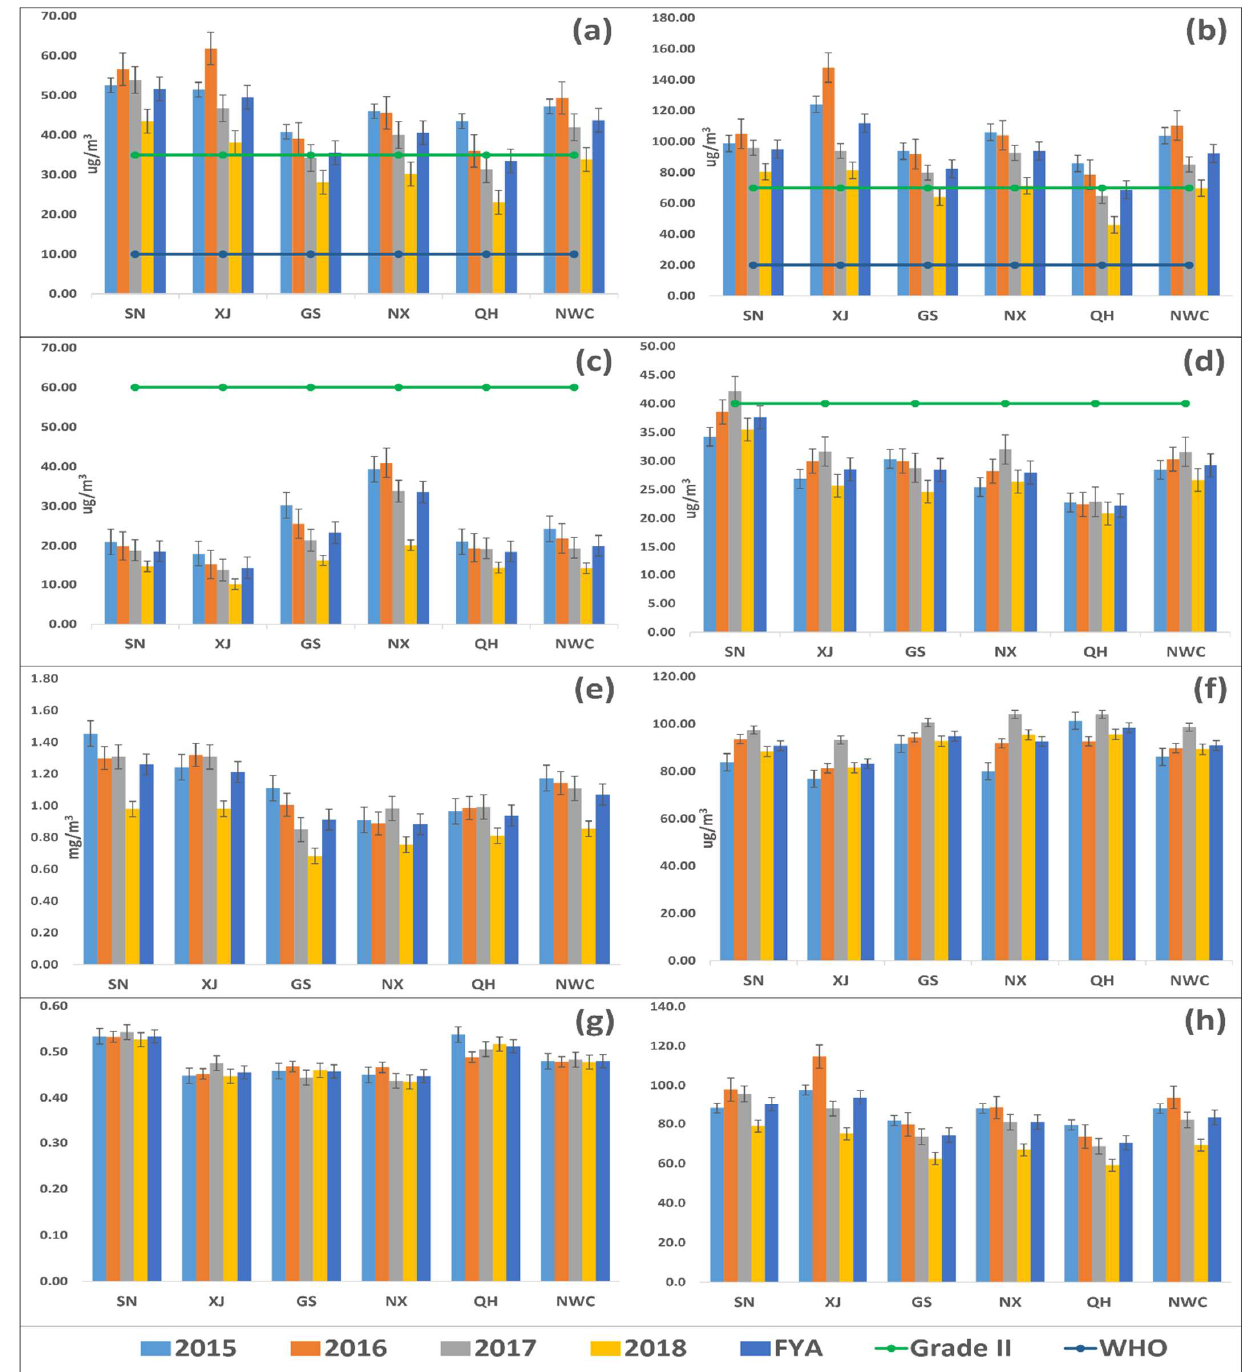
Figure 1. Annual variation of PM 2.5 ( a ), PM 10 ( b ), SO 2 ( c ), NO 2 ( d ), CO ( e ), O 3 ( f ), PM 2.5 /PM 10 ( g ), and AQI ( h ) in five provinces (Shaanxi (SN), Xinjiang (XJ), Gansu (GS), Ningxia (NX), and Qinghai (QH)) of northwest China (NWC) and NWC as a whole between 2015 and 2018. Descriptions are as follows: light blue bar (2015), orange bar (2016), grey bar (2017), yellow bar (2018), blue bar (four-year average (FYA)), parrot line with dots (CAAQS Grade II standards, annual mean), and dark blue with dots (WHO standards). The abbreviations are as follows: PM 2.5 (fine particulate matter), PM 10 (coarse particulate matter), SO 2 (sulfur dioxide), NO 2 (nitrogen dioxide), CO (carbon monoxide), O 3 (ozone), PM 2.5 /PM 10 (ratio of PM 2.5 with PM 10 ), and AQI (air quality index).